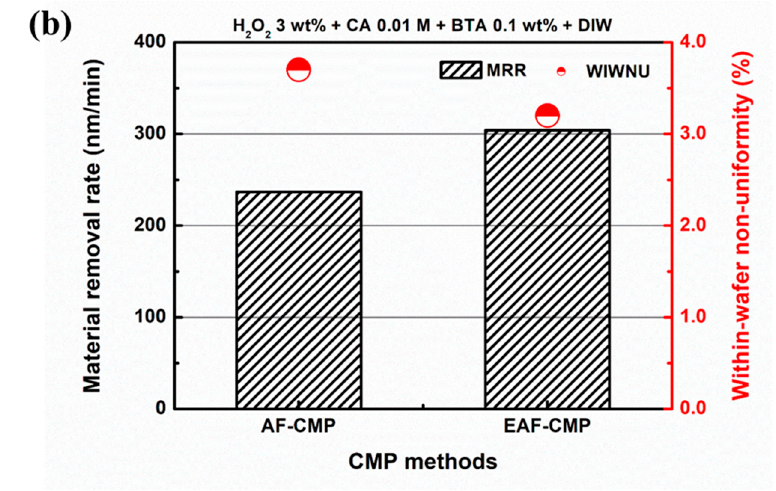
Figure 6. CMP results of AF-CMP and EAF-CMP; ( a ) MRR distribution and ( b ) average MRR and WIWNU.